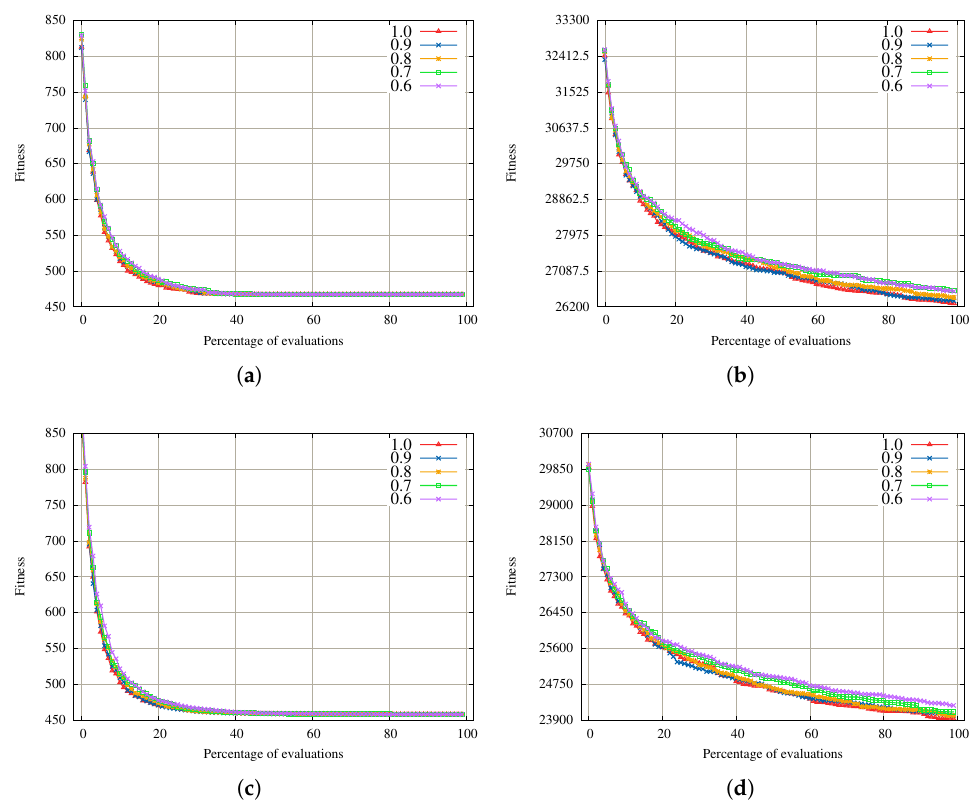
Figure 5. Crossover rate sensitivity for the GA. ( a ) Instance 1 from the small set (Small 1 ). ( b ) Instance 1 from the large set Large 1 . ( c ) Instance 2 from the small set (Small 2 ). ( d ) Instance 5 from the large set (Large 5